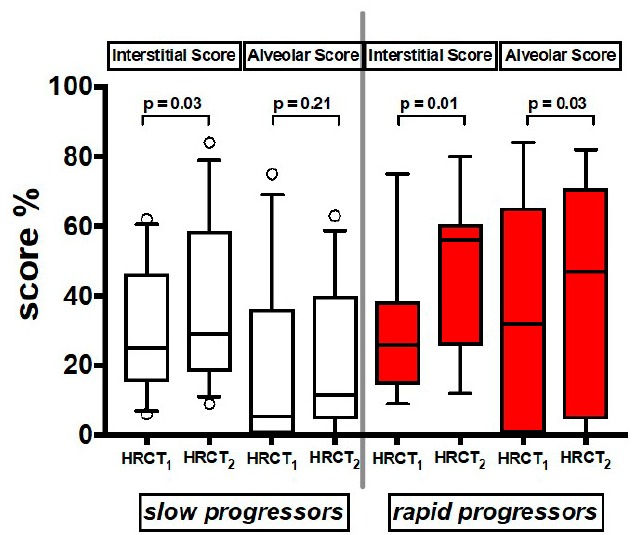
Figure 4. Values of Interstitial Score and Alveolar Score of the two serial HRCT scans (HRCT 1 at baseline and HRCT 2 at follow up). Horizontal bars represent median values; bottom and top of each box plot 25th and 75th; brackets show 10th and 90th percentiles; and circles represent outliers. White boxes indicate slow progressors and red boxes rapid progressors.